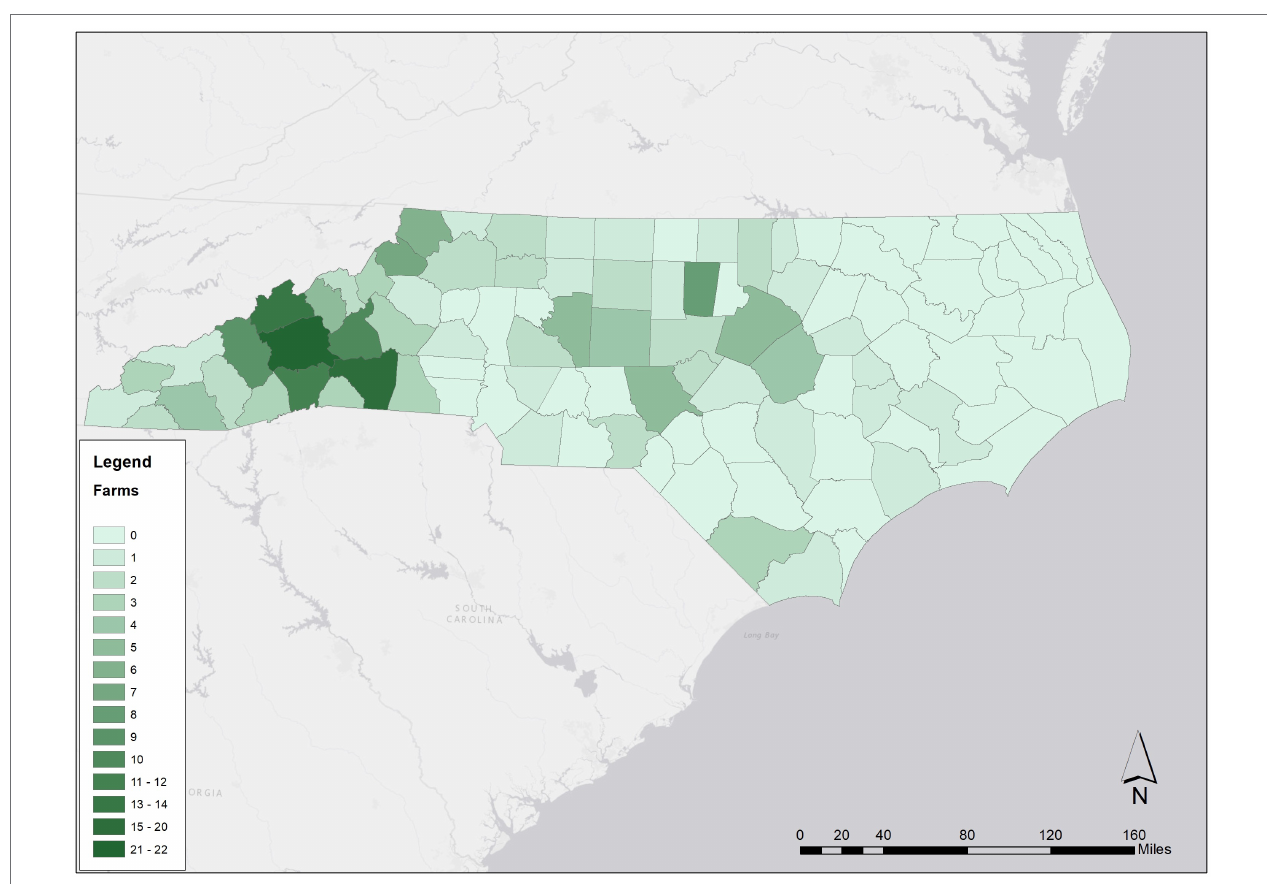
FIGURE 3 | Number of study participants per